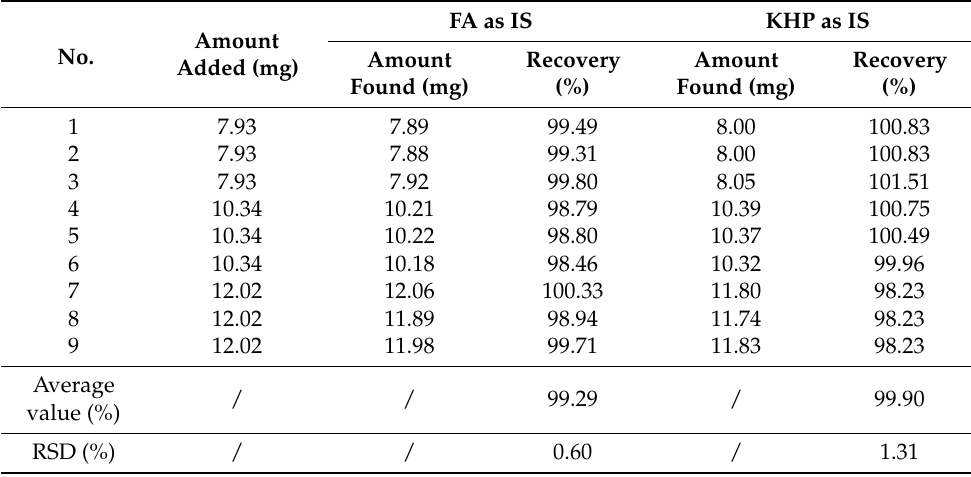
Table 3. Recovery of dipotassium glycyrrhizinate by qNMR.